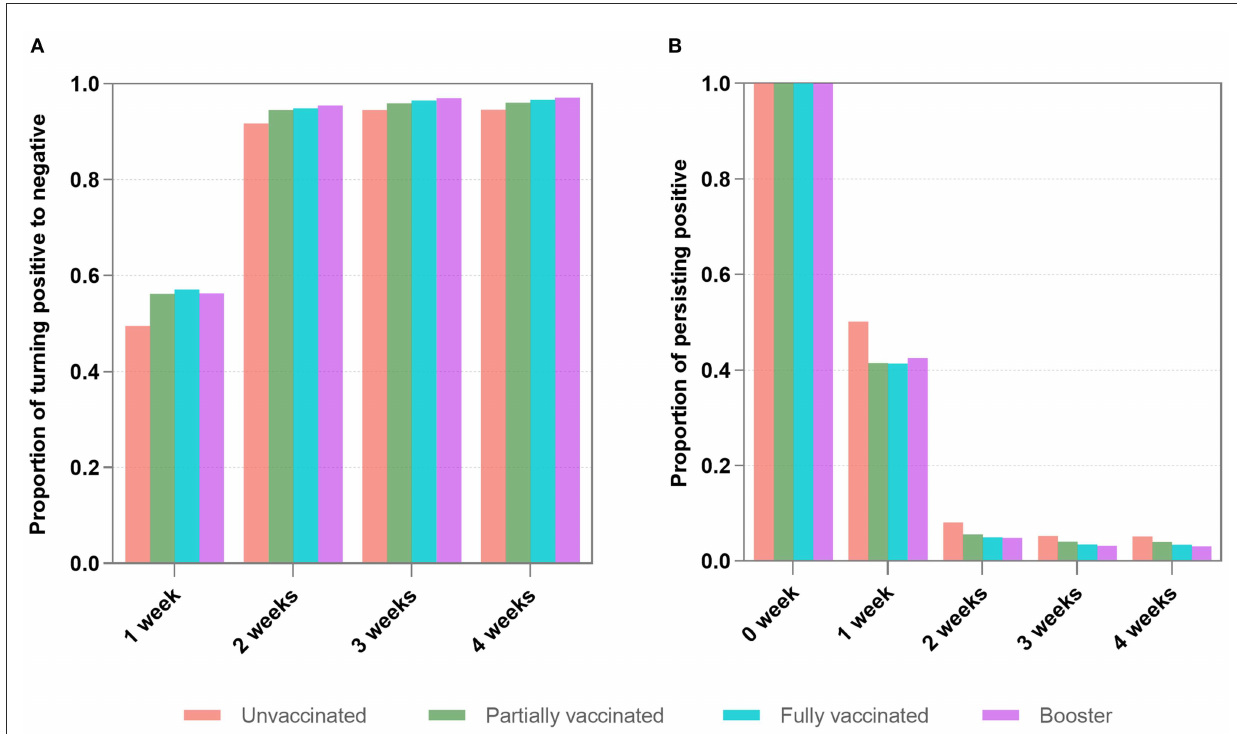
FIGURE2 The proportions of turning positive to negative (A) and persisting positive (B) within 4 weeks. (A) Shows that 54.7% of infected individuals achieved negative conversion after 1 week, and 94.3% achieved negative conversion after 2 weeks (2 weeks vs. 1 week , P < 0.001). There were significant differences in negative changes between 3-, 4, and 1-week ( P < 0.001), but they were not statistically significant between the three and 4 weeks ( P = 0.48). (B) Reveals that 6.5% of infected individuals remained positive after 2 weeks. There were no significant differences between the proportions after three and 4 weeks ( P =